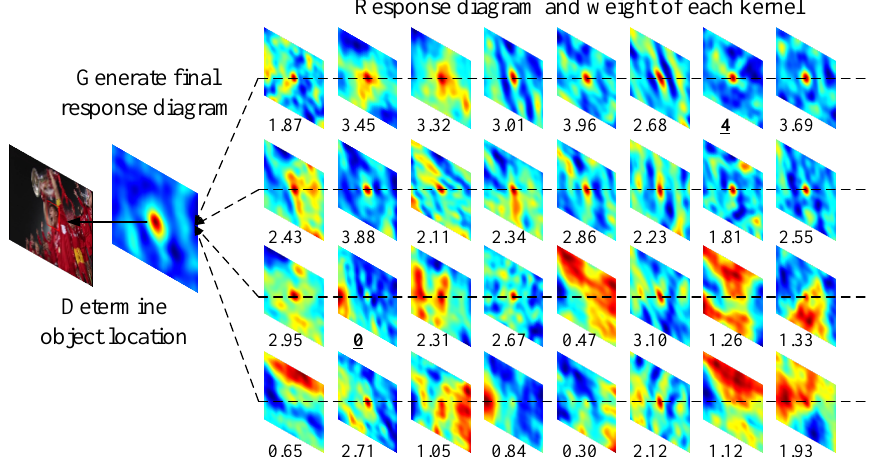
Figure 8. The proposed attention module weighting results for each convolution kernel (“soccer” video sequence).